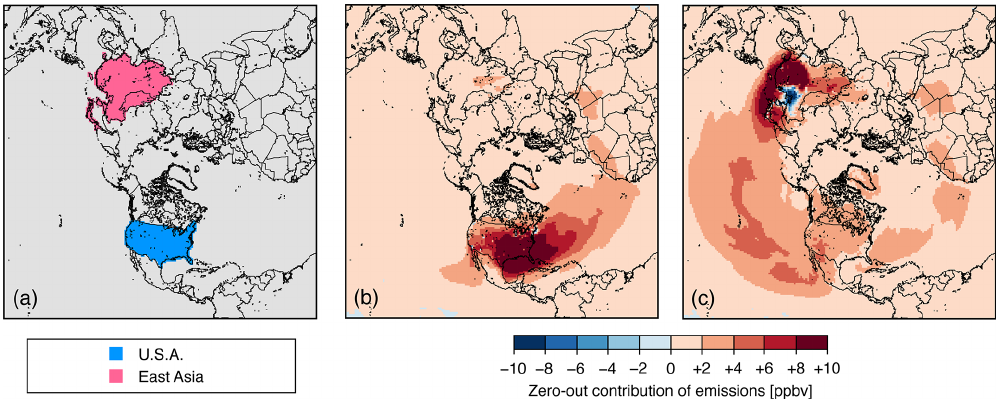
Figure 3. (a) Source regions of the US and east Asia, and zero-out contribution of emissions from the (b) US and (c) east Asia during April 2010. East Asia is defined as China, Taiwan, Mongolia, the Republic of Korea, Democratic People’s Republic of Korea, and Japan. Table 1. Summary of the correlation between modeled MD8O3 and the zero-out contribution of emissions from the US and east Asia. N Emission impacts Emission impacts from the US from east Asia All CASTNET sites 2286 0.63 ∗∗∗ − 0 . 03 – Pacific Standard Time (PST) 238 0.52 ∗∗∗ 0.38 ∗∗∗ – Mountain Standard Time (MST) 359 0.65 ∗∗∗ 0.36 ∗∗∗ – Central Standard Time (CST) 489 0.55 ∗∗∗ 0.06 – Eastern Standard Time (EST) 1200 0.64 ∗∗∗ − 0 . 02 Elevated CASTNET sites 587 0.52 ∗∗∗ 0.22